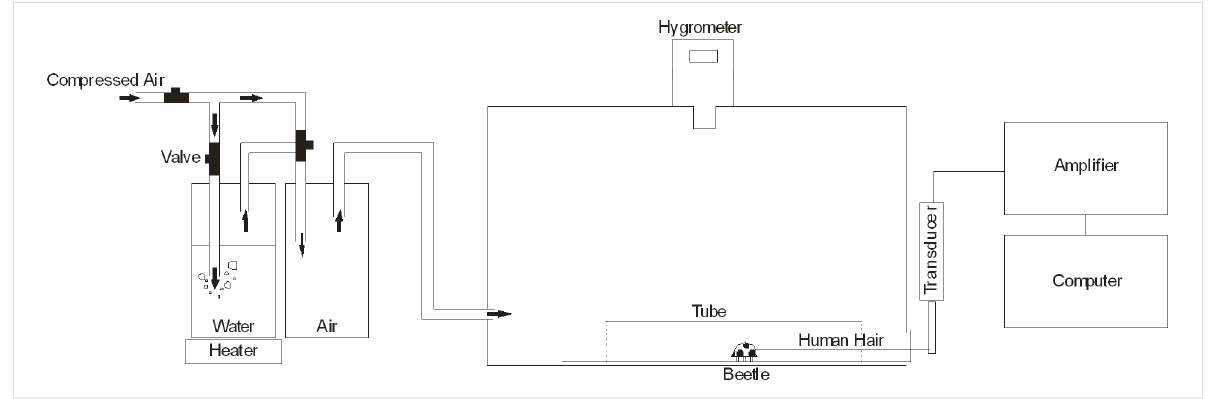
Figure 2: Schematic of the experimental setup used for traction force experiments under controlled ambient humidities. Tethered beetles were connected to a force sensor by a 15–20 cm long human hair. Humidity was controlled by mixing dry compressed air (approx. 15% relative humidity) and wet air. Wet air was produced by heating water in a glass bottle, in order to increase the amount of water vapour. Temperature was continuously monitored in the chamber to ensure that the use of the heater did not lead to temperature increase within the chamber. For details, see